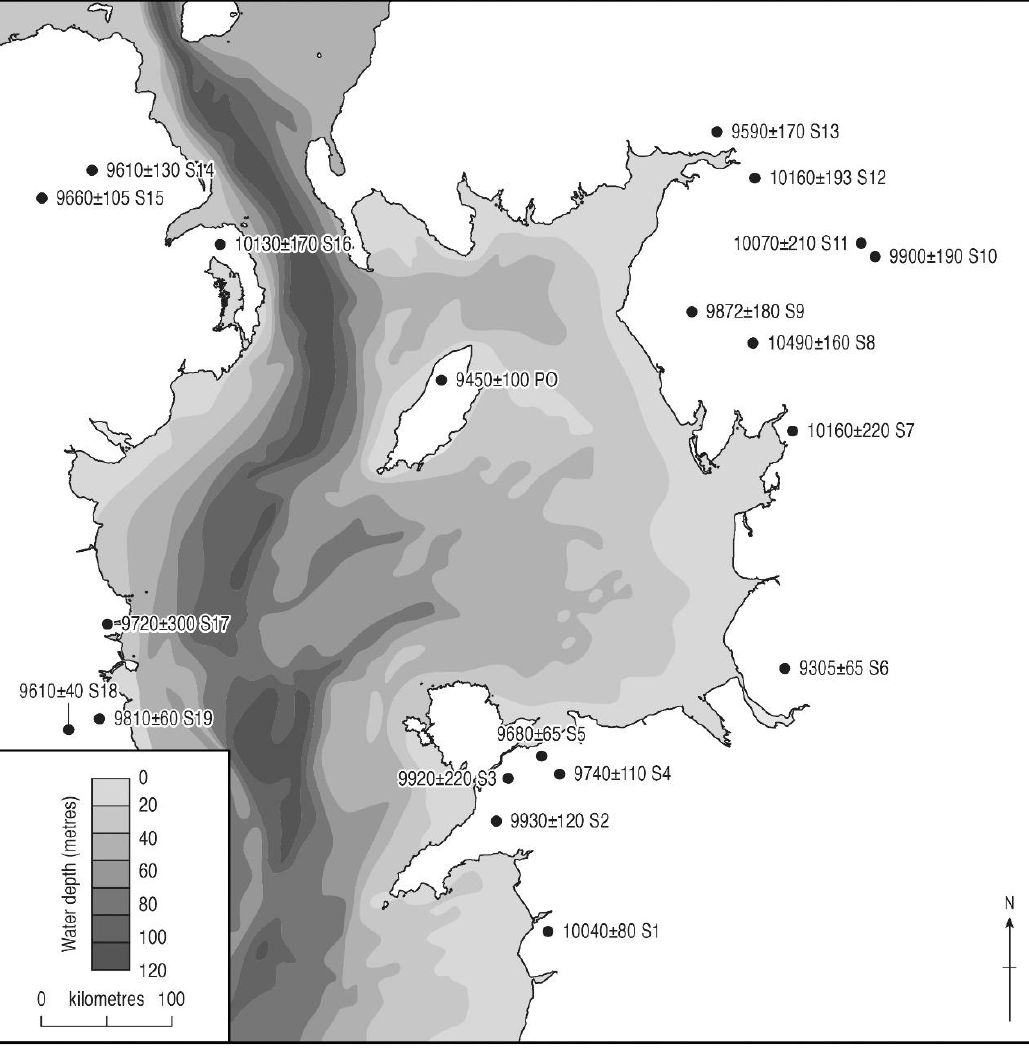
Figure 10. Radiocarbon ages for the Juniperus maximum in the northern Irish Sea region. For sources and date calibration ranges see Supplementary File S1.